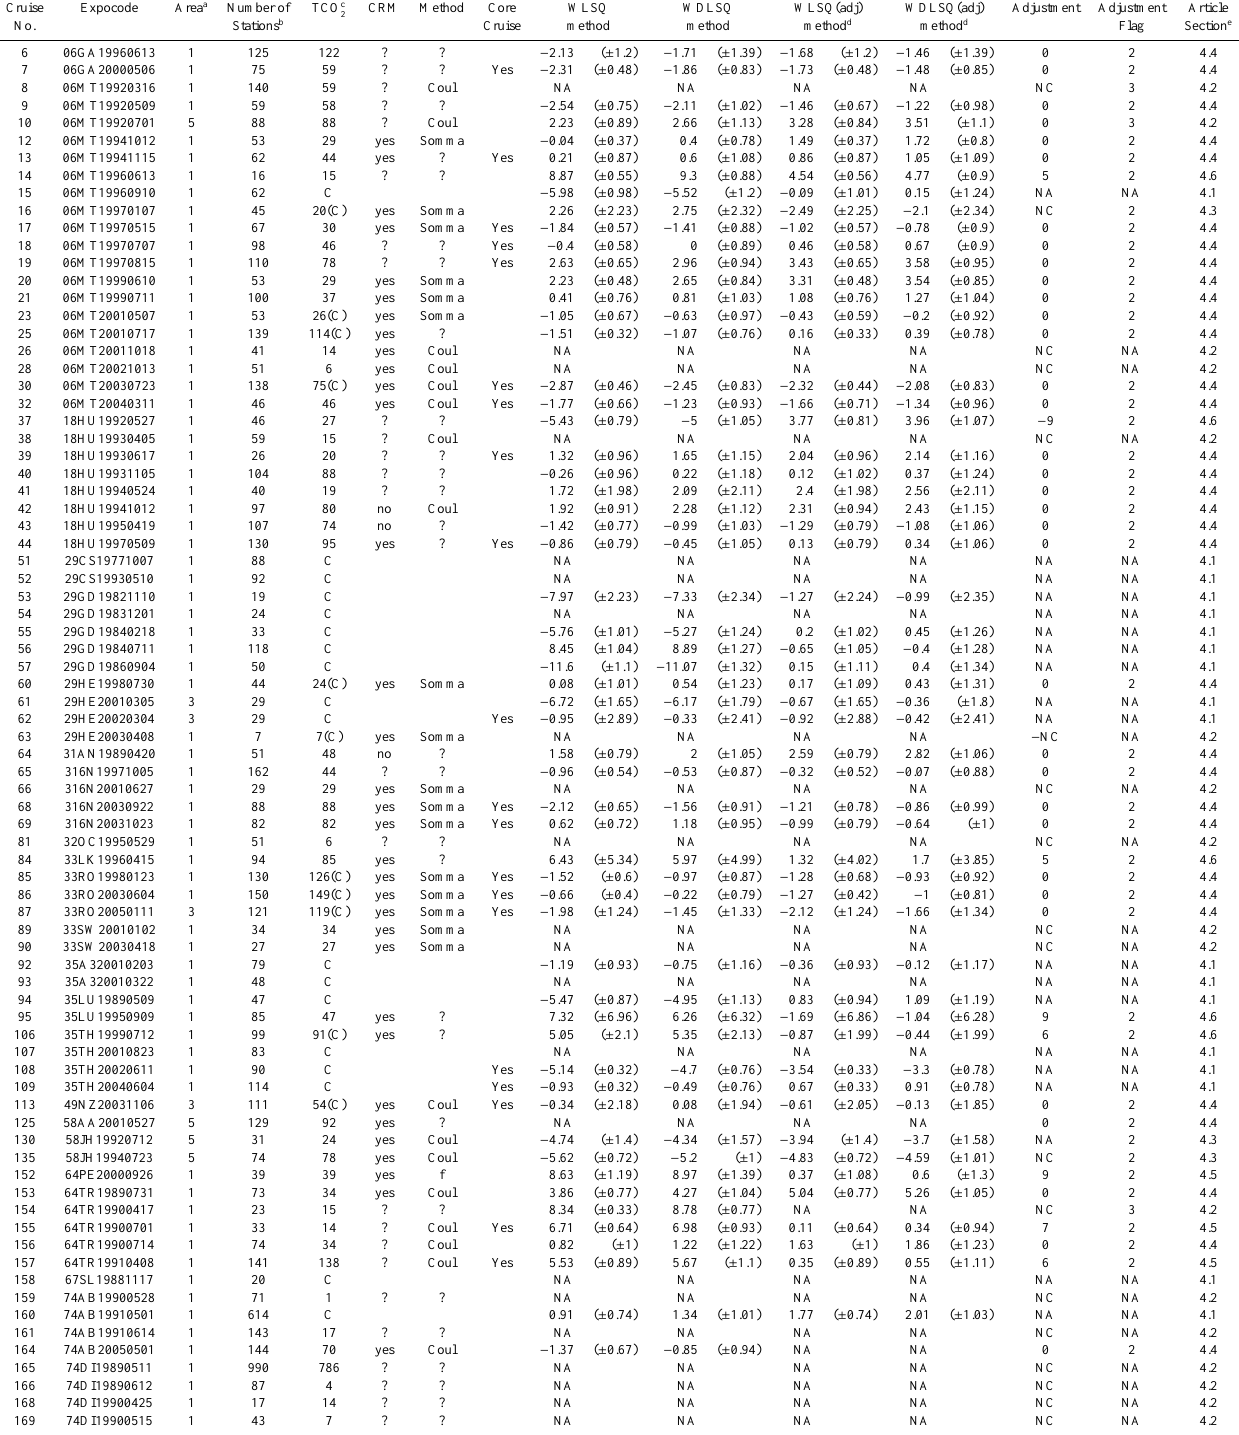
Table 1. List of the cruises considered in CARINA-ATL and the associated information regarding their TCO 2 data. A question mark refers to information unavailable at the time this article was published. The last columns give the results in µ molkg − 1 of the di ff erent inversions (WLSQ and WDLSQ) performed as described in the text and the final adjustments ( µ molkg − 1 ) which were applied to the data to produce the final self-consistent CARINA-ATL data